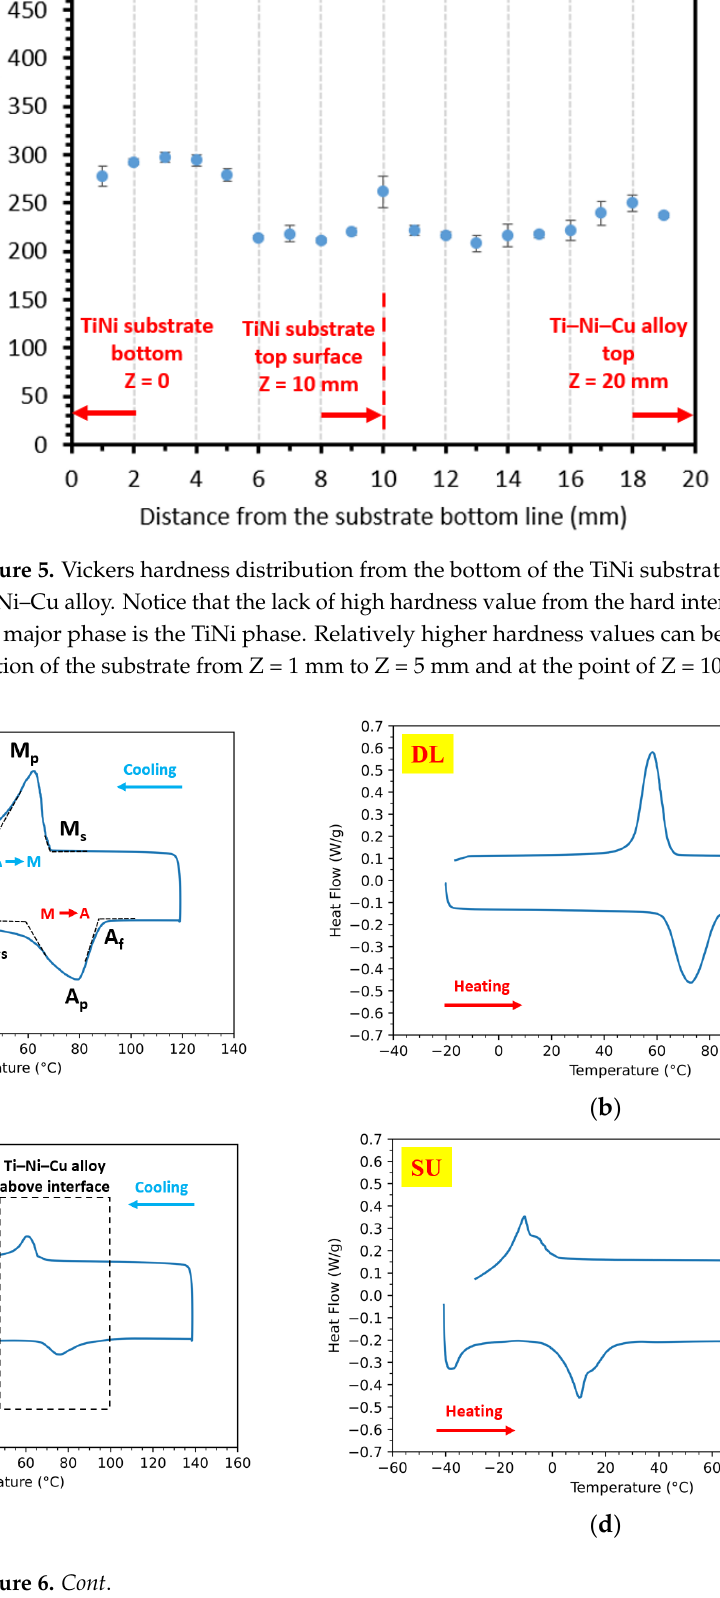
( f ) Figure 6. DSC heating–cooling curves of the six regions (marked in Figure 1b) of the as-deposited bi-metallic SMA. ( a ) The upper part of the DED Ti–Ni–Cu alloy (DU). The characterization temper- atures: austenite starting temperature (A s ), austenite peak temperature (A p ), austenite finishing tem- perature (A f ), martensite starting temperature (M s ), martensite peak temperature (M p ), and marten- site finishing temperature (M f ) are labeled. ( b ) The lower part of the DED Ti–Ni–Cu alloy (DL). ( c ) The interfacial region (IN). Notice that there are two distinctive phase-transformation peaks during heating and cooling from Ti–Ni–Cu alloy and TiNi substrate, which are marked by dashed boxes. ( d ) The upper part of the substrate (SU). ( e ) The middle part of the substrate (SM). ( f ) The lower part of the substrate (SL). Table 1 summarizes the A f of all sections. Figure 6 shows that the Ti-rich upper Ti– Ni–Cu alloy shows a higher austenite finishing temperature A f . As for the sections DU and DL, the TiNi matrix is highly Ti-rich and the A f reaches higher than 80 °C. The DSC curve of the IN sample with the interface has two distinctive peaks both during heating